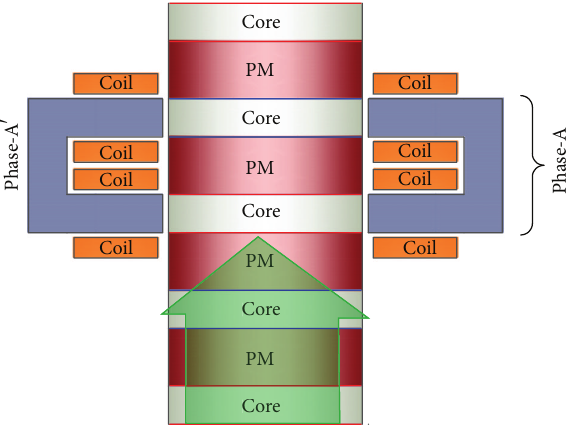
Figure 2: Position of the translator for time 𝑡 1